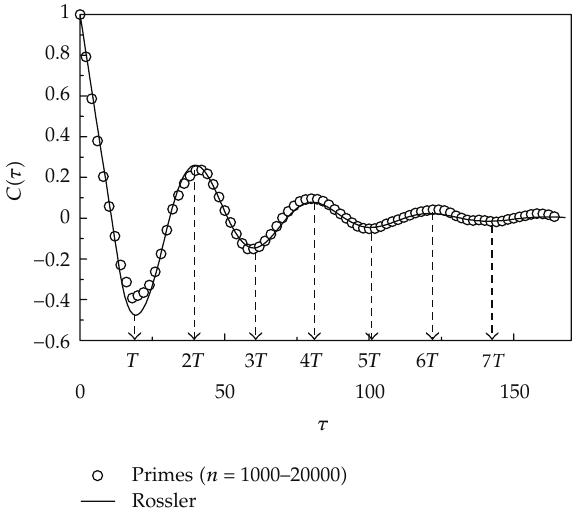
Figure 2: As in Figure 1 but for interval 1000 < n < 2 × 10 4